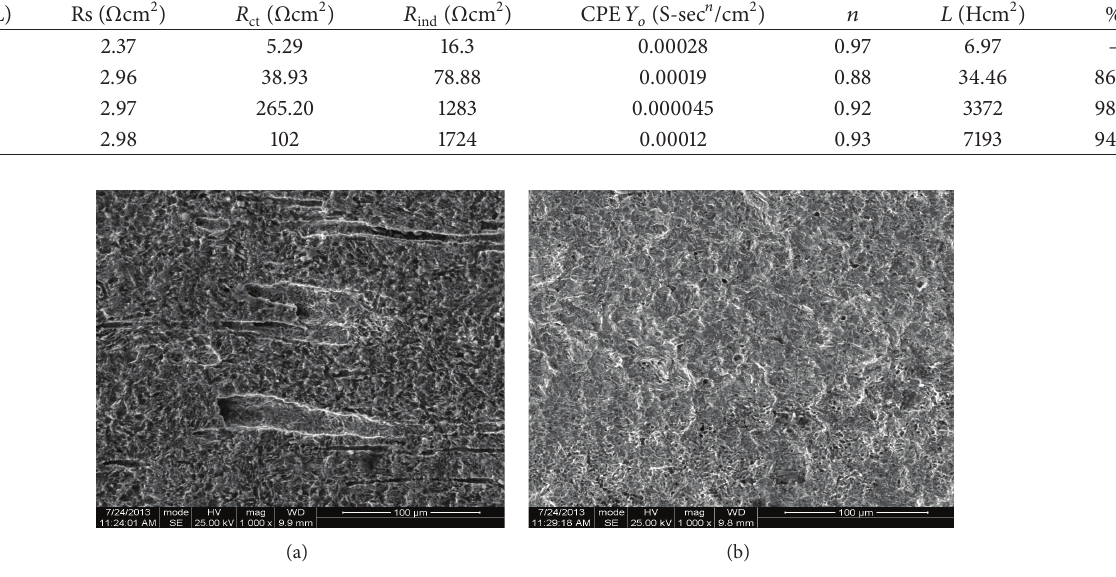
Table 6: Impedance parameters for pipe steel in 0.5 M H